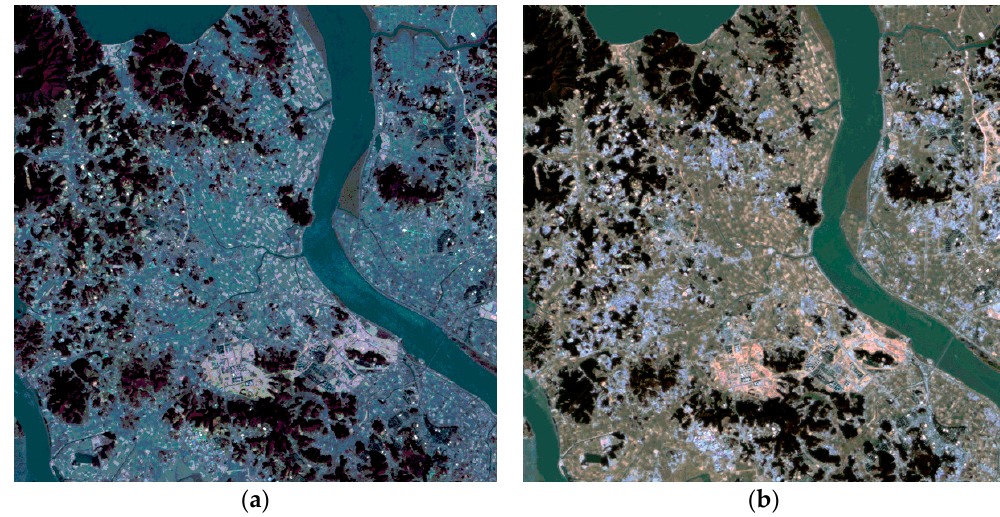
Figure 10. Normalized subject image: ( a ) AdaBoost regression; and ( b ) SGB regression. Table 5. Statistical results (R 2 and RMSE) of AdaBoost and SGB regression normalization.